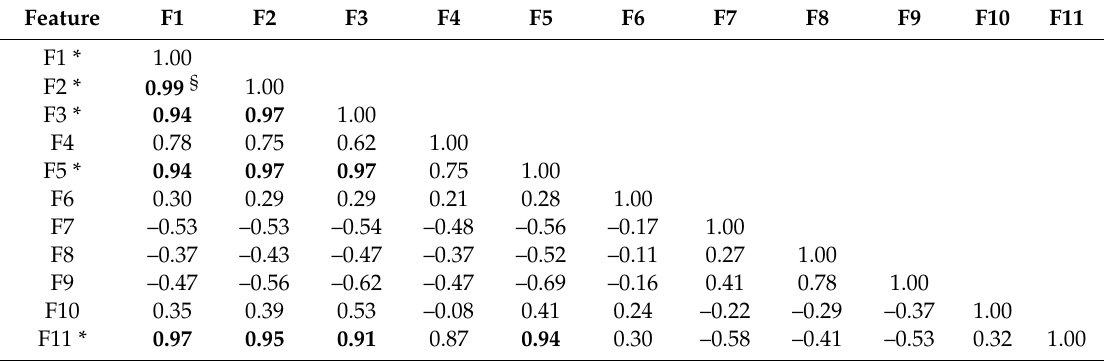
Table 4. Correlation matrix between features. Features with * are highly correlated ( r > 0.9).